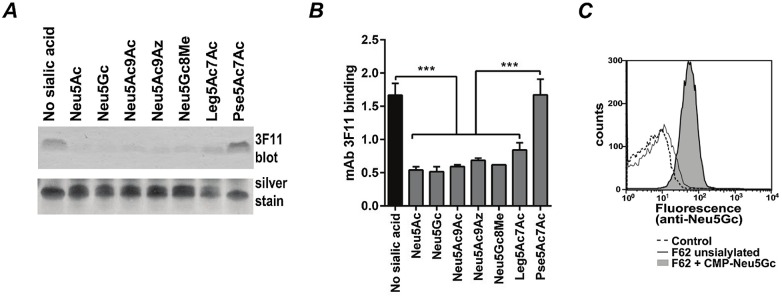
Substrate specificity of gonococcal LOS sialyltransferase (Lst).
A. N. gonorrhoeae (Ng) strain F62 ΔlgtD was grown in gonococcal media alone (‘No sialic acid’) or in media supplemented with CMP salts of the indicated sialic acid (Sia), each at a concentration of 20 μg/ml (30 μM), for 2 h at 37°C. Bacteria were washed, pellets treated with protease K, lysed in 4× LDS buffer and lysates were separated on 12% Bis-Tris gels using MES running buffer. LOS was transferred to a PVDF membrane and probed with monoclonal antibody (mAb) 3F11 that recognizes the lacto-N-neotetraose only in the non-sialylated state; the addition of a Sia residue abrogates mAb 3F11 binding (upper panel). LOS was also visualized by silver staining following electrophoresis on 16.5% tricine gels (lower panel). B. Incorporation of NulO by LNnT LOS was assessed using whole cell ELISA with mAb 3F11, *** P<0.001. C. Wild-type Ng F62 was grown with (shaded) or without (solid line) 30 μM CMP-Neu5Gc for 3 hours and analyzed by flow cytometry using a polyclonal Neu5Gc-specific chicken IgY Ab followed by a FITC conjugated donkey anti-chicken IgY secondary Ab. As a negative control, wild-type Ng F62 was grown in CMP-Neu5Gc as above and incubated with the secondary Ab only (dashed line).